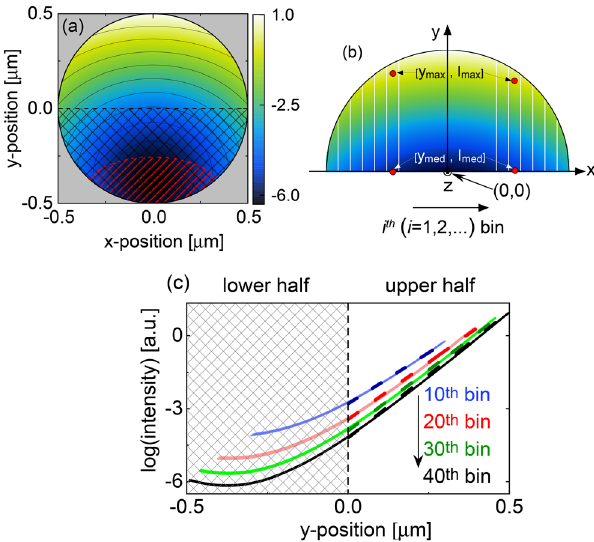
Figure 2: (a) Simulated spatial intensity distribution (logarithmic color scale including iso-intensity contour lines) in a circular water- filled microchannel (diameter D m (cid:1) 1 μ m , λ (cid:1) 642 nm). The correla- tion between the local fi eld intensity and the y -coordinates is ambiguous in the red-shaded area and position retrieval is per- formed in the upper semicircle. (b) Close-up of the intensity distri- butionintheuppersemicircleofthemicrochannelThewhitevertical lines indicate the boundaries between the adjacent bins along the x -direction. In each bin, the highest scattered intensity occurs when the particle is at the upper channel wall indicated by y max (center of the particle). The median scattered intensity is expected to be at y med = 0 (see text for details). (c) Intensity distribution along the y -direction of selected bins in case of 100 bins partitioning (bin width10nm).Exponential fi ttingisappliedtothepointsintheupper semicircle (nonhashed area) for each bin, representing by the dashed curves in corresponding darker